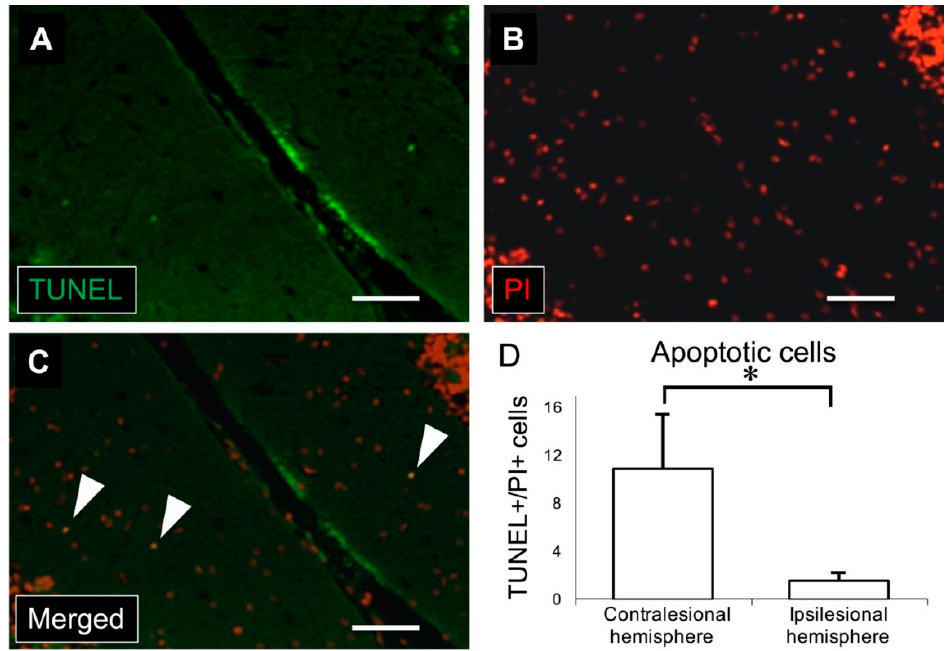
Figure 5. ( A ) Immunostaining for TUNEL (green) shows apoptotic cells in the molecular layer of the cerebellar cortex. ( B ) Nuclei were stained with PI in red. ( C ) Merged image of TUNEL and PI immunostaining. White arrowheads indicate TUNEL / PI-positive cells. ( D ) There was a significant increase in the number of TUNEL / PI-positive cells in the contralesional (left) cerebellar cortex compared to the ipsilesional (right) cerebellar cortex (scale bar: 50 µ m, * p < 0.001, n = 11 in each group). TUNEL: terminal deoxynucleotidyl transferase deoxyuridine triphosphate nick-end labeling, PI: propidium iodide.